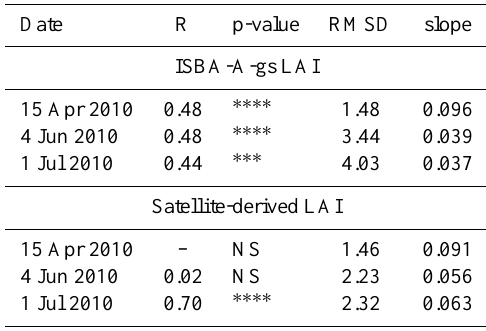
Table 3. Spatial correlation coefficient ( R ), p-value, RMSD, and the slopes of the regression lines (Fig. 8) between ISBA-A-gs/satellite derived LAI and the CAROLS